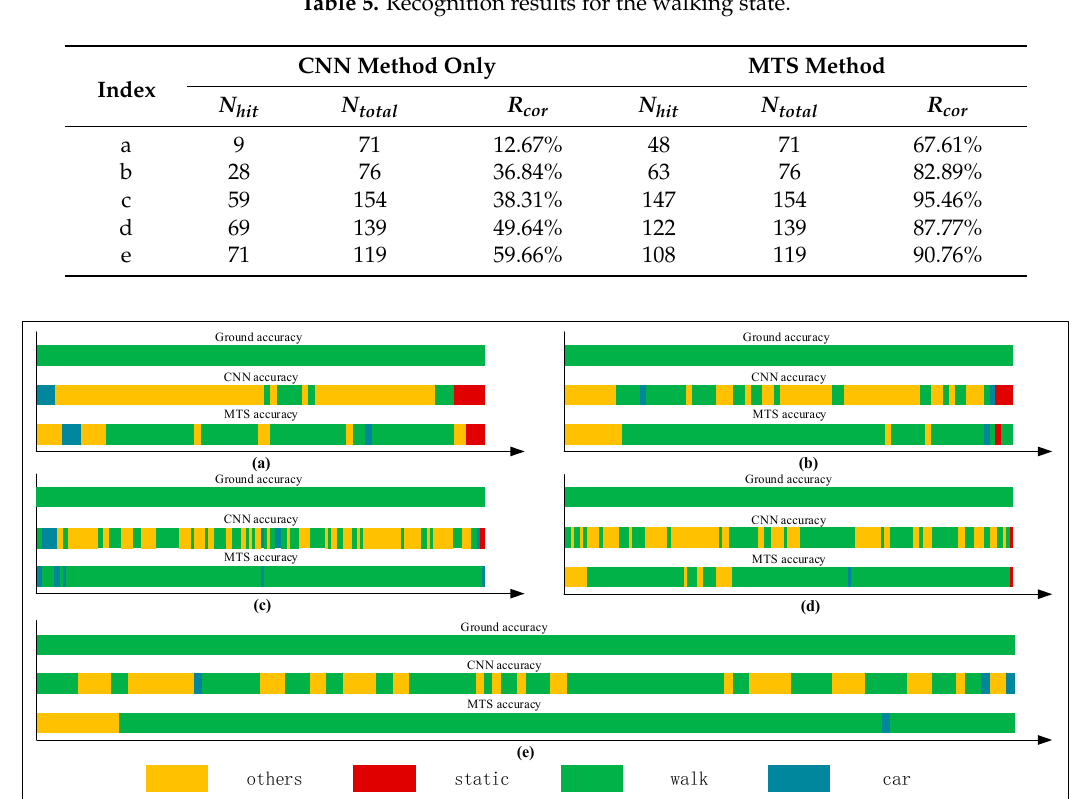
Figure 14. Graphs showing recognition of the walking